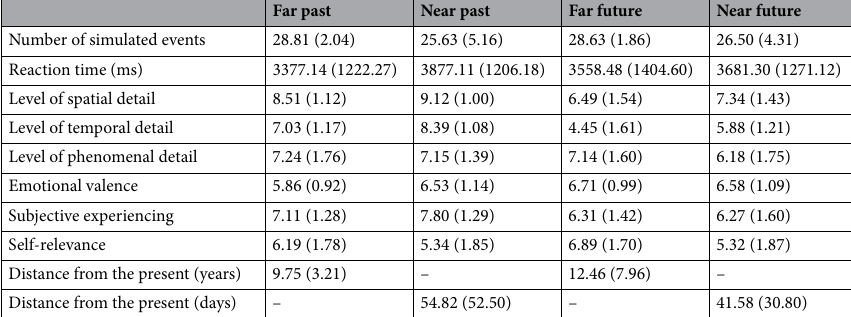
Table 2. Behavioral data . Mean (standard deviation in parenthesis) number of simulated events, reaction time, and responses to the TEMPau scales as a function of time and temporal